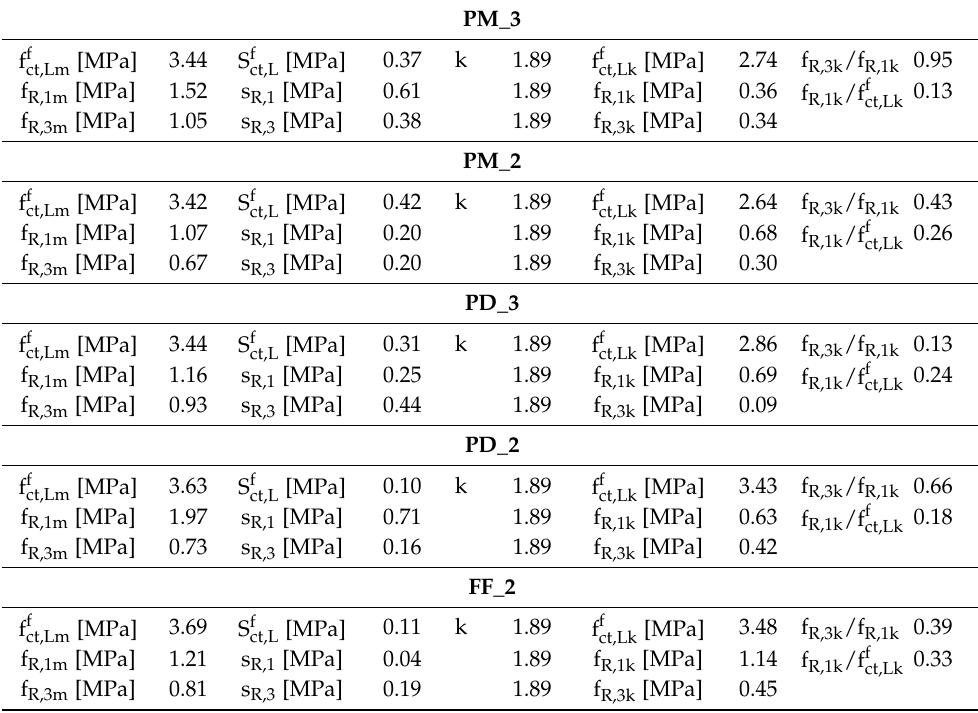
Table 12. FRC classification according to Model Code 2010